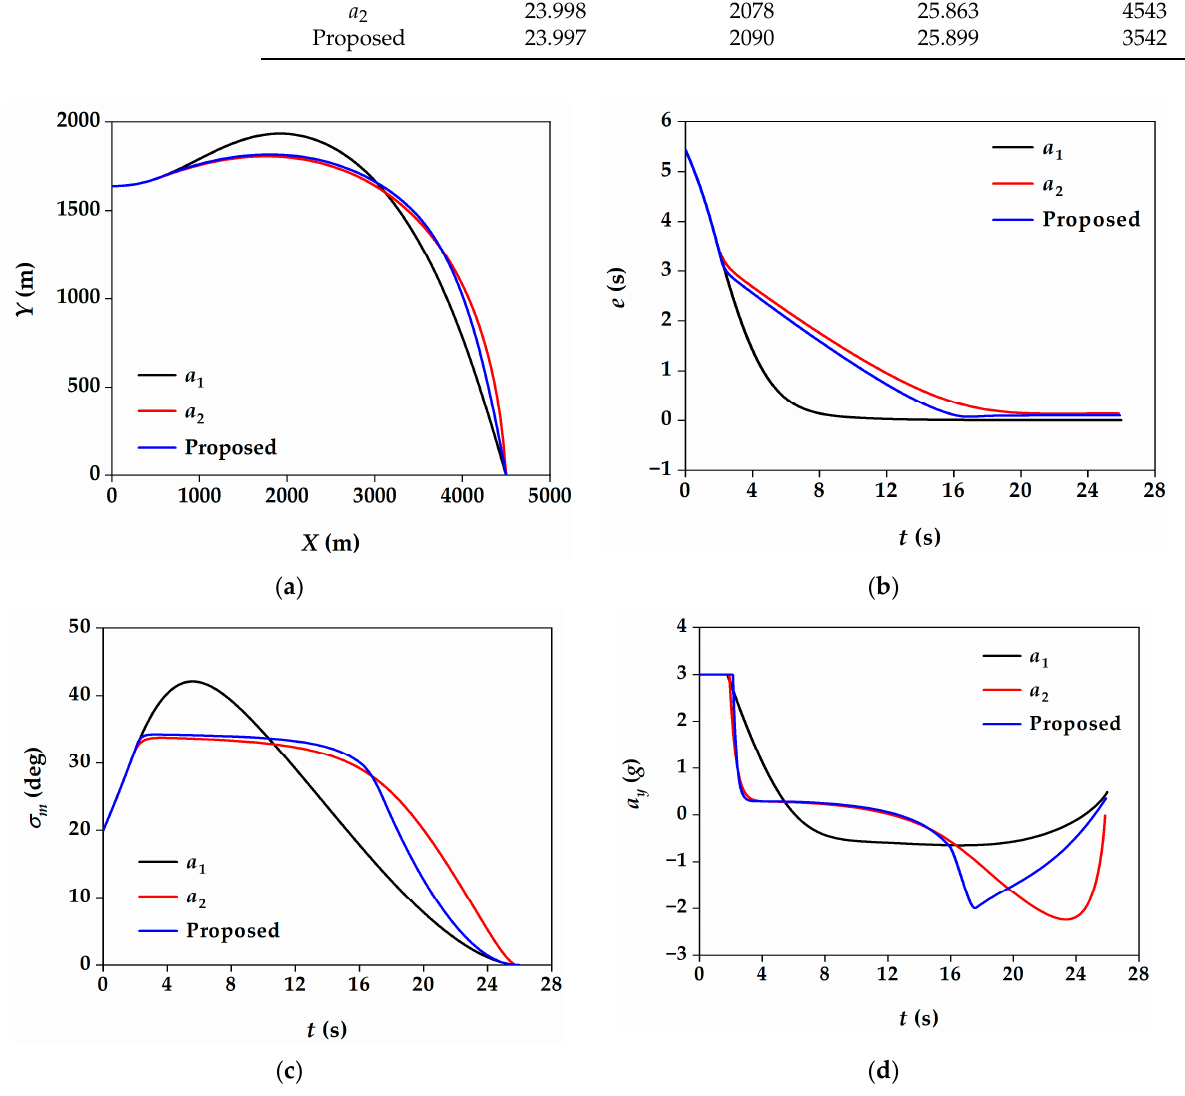
Figure 7. Comparison of simulation results under scenario 2. ( a ) Projectile flight trajectory; ( b ) impact time error; ( c ) lead angle; ( d ) normal acceleration.